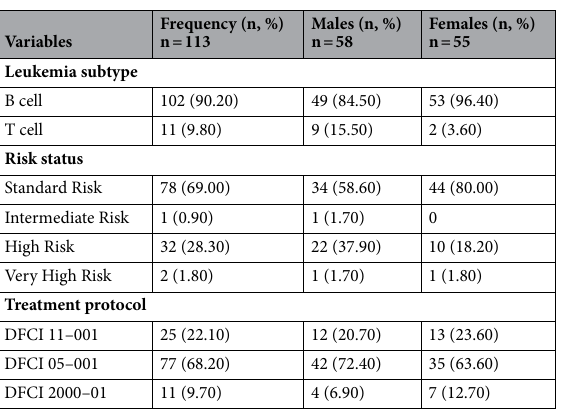
Table 3. Leukemia subtype, risk status, and treatment details. ALL Acute Lymphoblastic Leukemia, DFCI Dana Farber Cancer Institute Protocol.